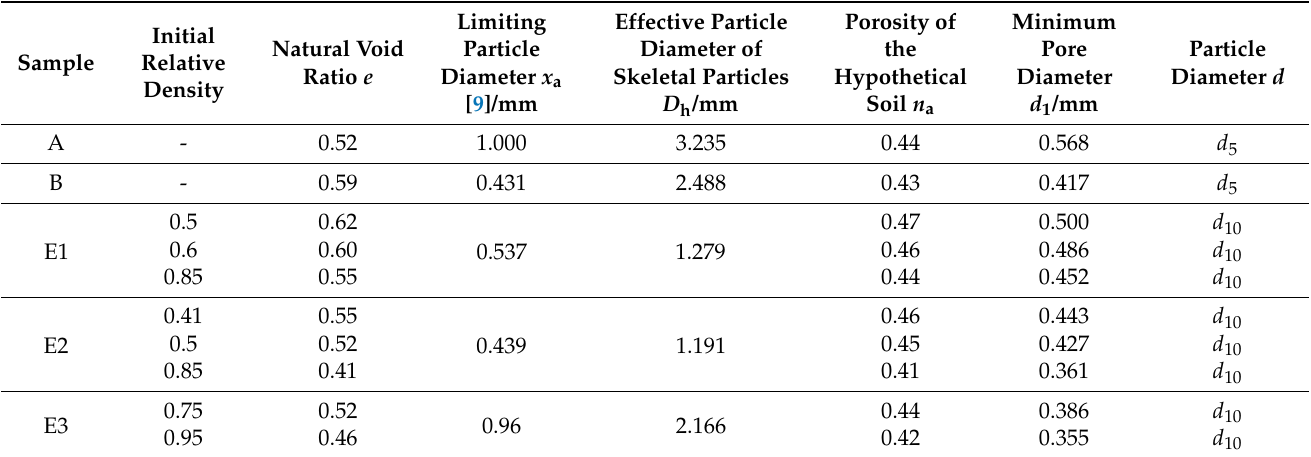
Table 3. Parameters of test soil